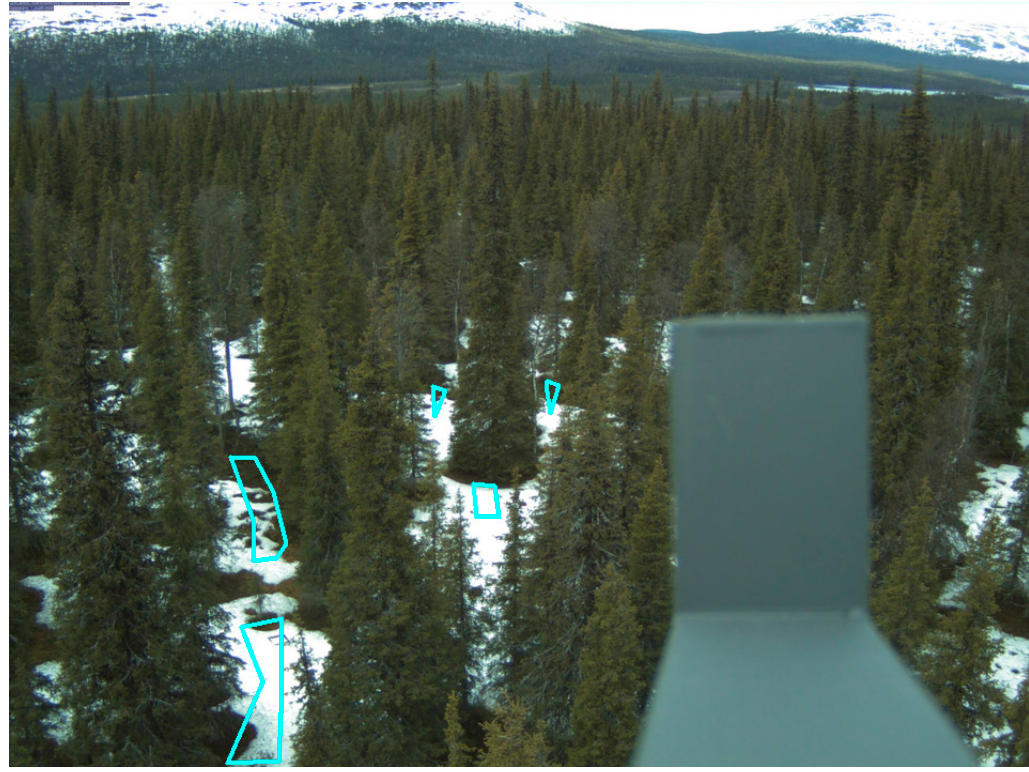
Figure 4. Kenttärova canopy camera ROI.